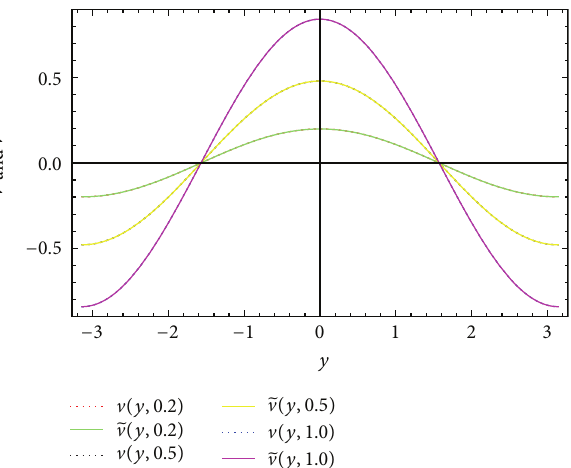
Figure 5: The approximate ̃ V and the exact V solutions for different values of 𝑡 = 0.2 , 0.5, and 1.0 of problem (45), where 𝑁 = 16 and 𝛼 = 𝛽 = 0 in the interval [−𝜋,𝜋]